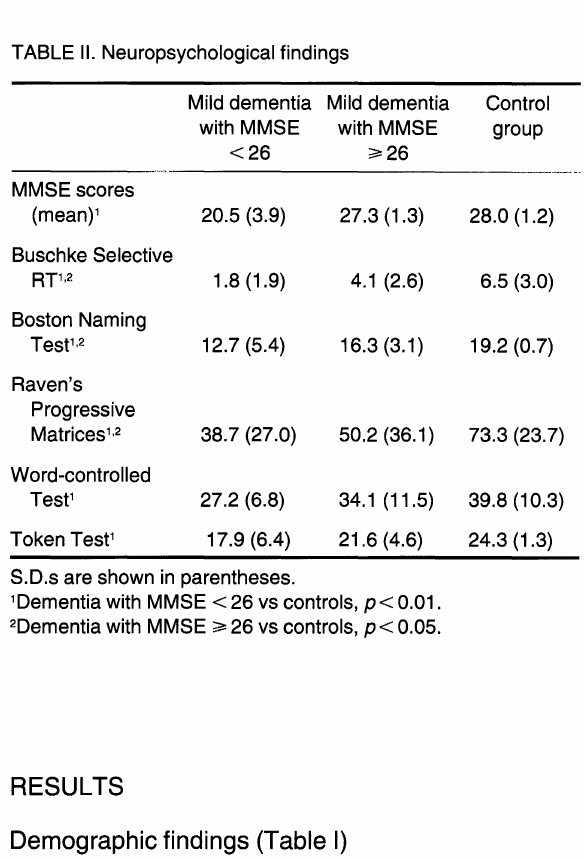
TABLE II. Neuropsychological findings Mild dementia Mild